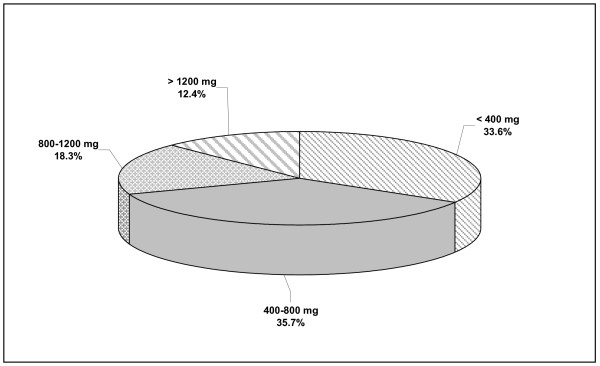
Daily amount of dietary calcium intake in total population. This figure depicts the daily amounts of dietary calcium intake (and percent) in total population.